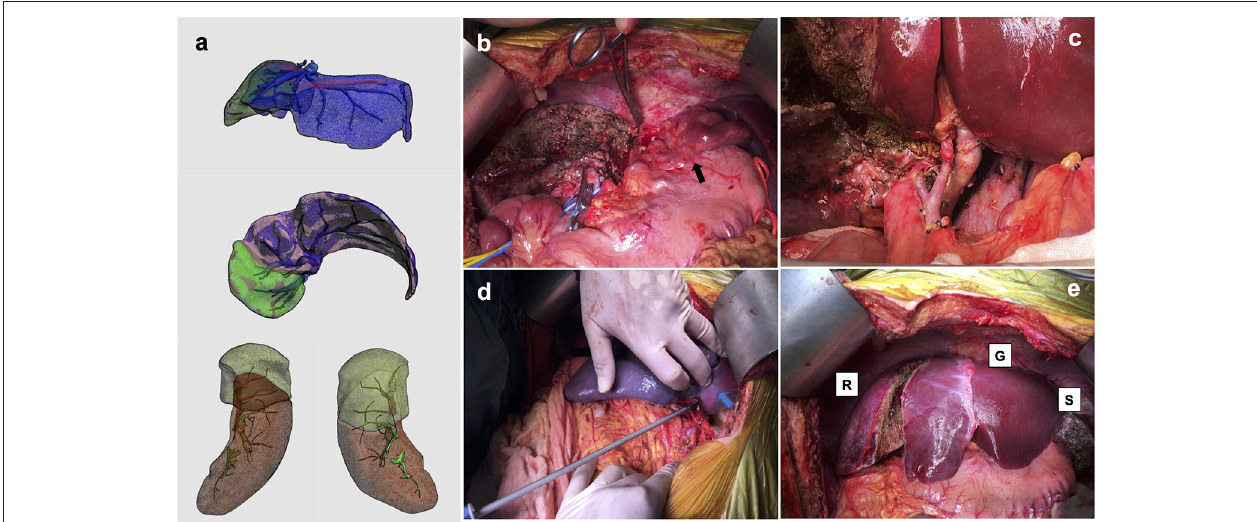
FIGURE 1 | Estimated hepatic and splenic volumes of the recipient and photographs of the operating field. (a) Calculated hepatic volume was 905ml (volume of planned preserved right hemi-liver was 270ml), and splenic volume was 1,445ml (volume of designed preserved upper pole was 503ml; (b) remnant right hemi-liver and large varicose veins (black arrow); (c) hepatic artery and portal vein to auxiliary partial graft; (d) ischemic demarcation line on spleen (blue arrow) during simultaneous subtotal splenectomy; (e) native remnant liver (R), partial liver graft (G) and residual spleen